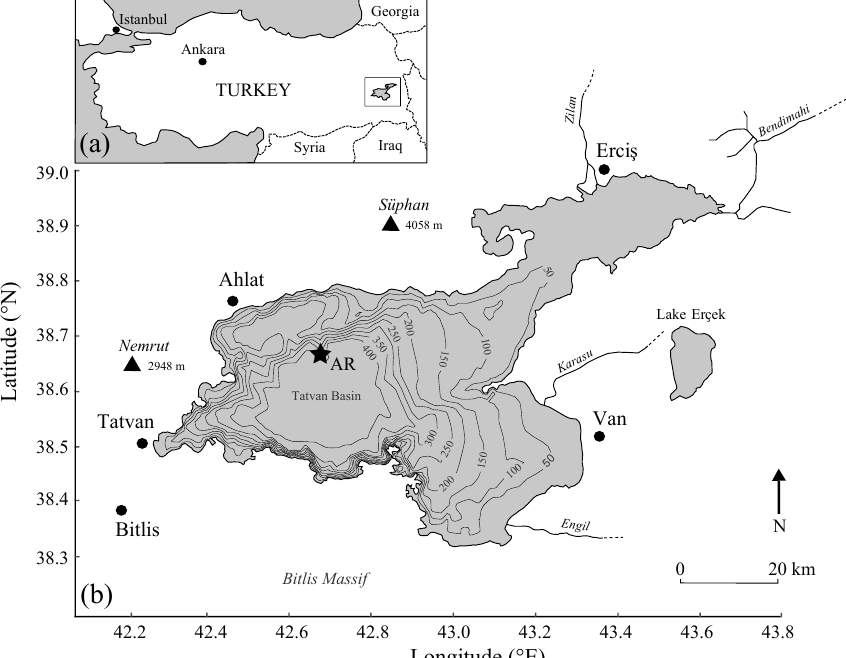
Figure 1. (a) Location of Lake Van in eastern Anatolia (Turkey) and (b) the bathymetry of Lake Van including the main ICDP drill site Ahlat Ridge (AR, black star). Major cities (black dots) and rivers are represented. The black triangle indicates the positions of the active volcanoes Nemrut and Süphan. The Bitlis Massif in the south reaches up to